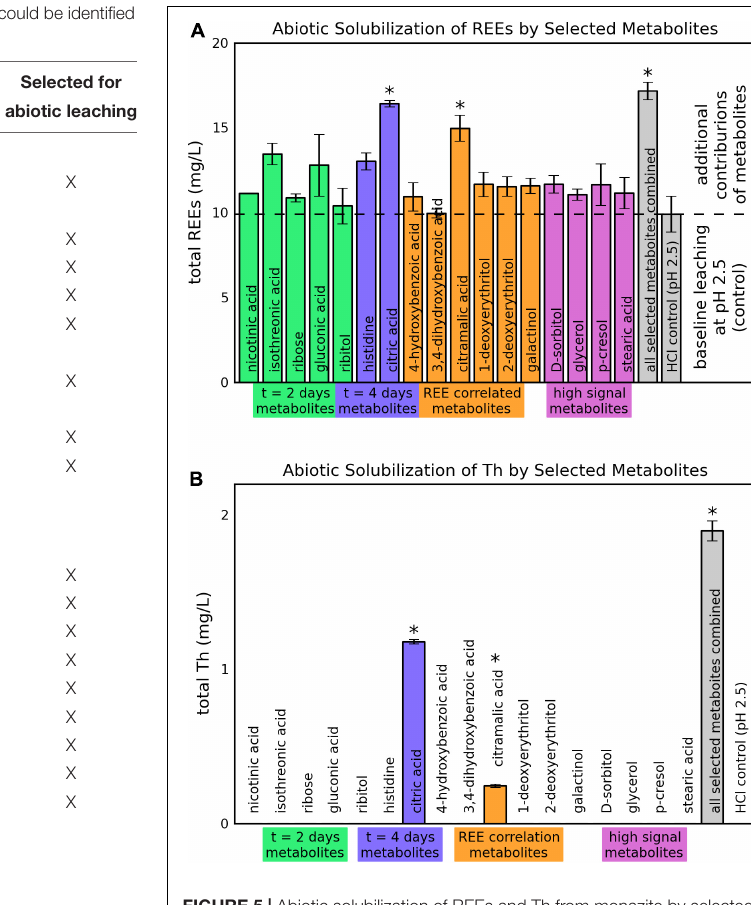
FIGURE 5 | Abiotic solubilization of REEs and Th from monazite by selected metabolites. Heights and error bars indicate means and standard deviations for three replicates. The ∗ symbol indicates a statistically significant increase in leaching compared to the control based on an adjusted p -value < 0.05. (A) REE solubilization. (B) Th